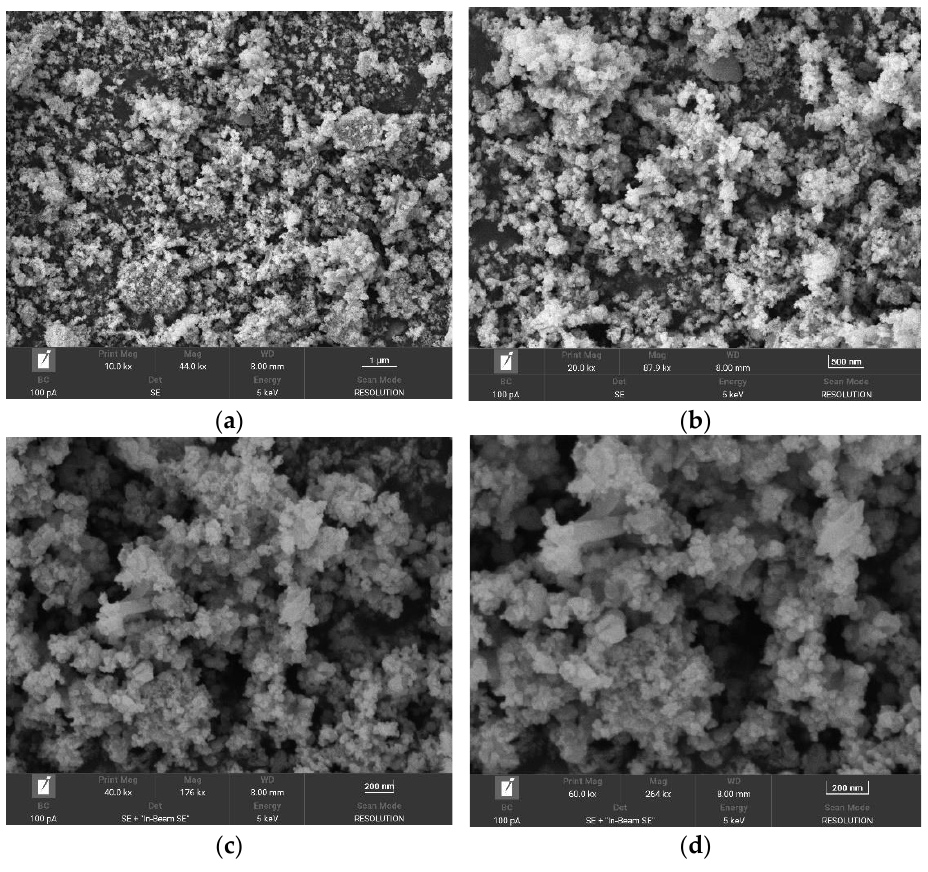
Figure 6. SEM of Fe 3 O 4 @ZIF-8 after adsorption. ( a – d ) show the effects of 10,000 times, 20,000 times, 40,000 times and 60,000 times magnification respectively.